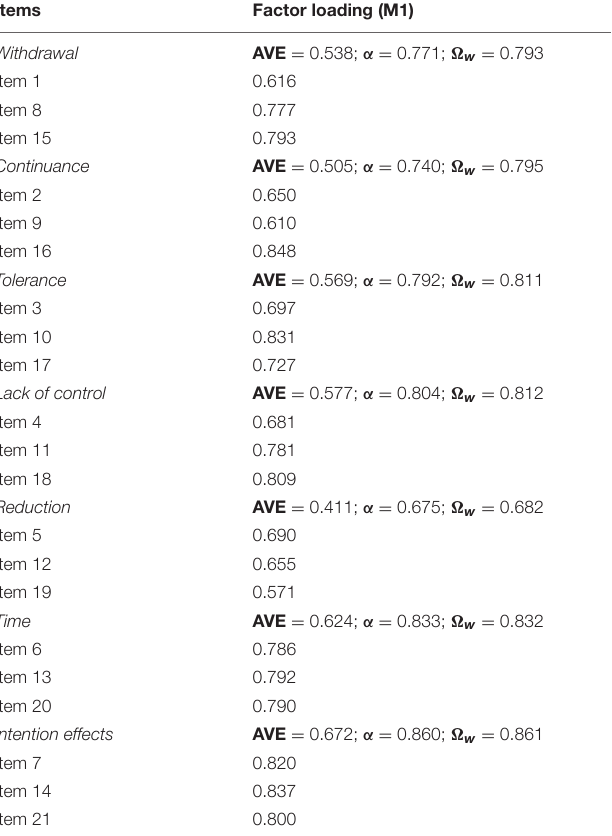
TABLE 2 | Standardized factor loadings and internal consistency